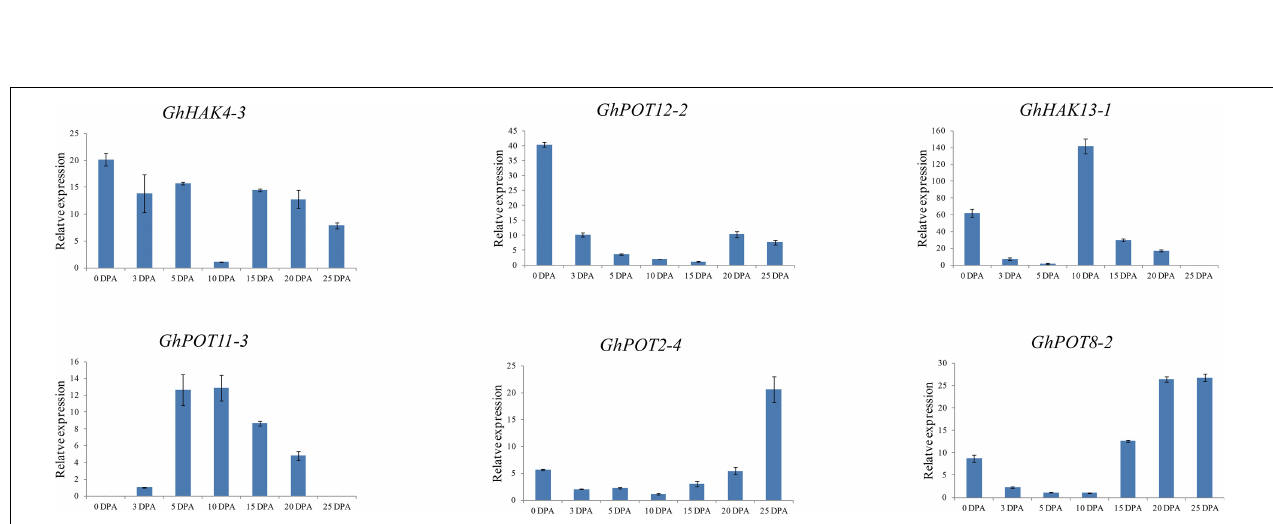
FIGURE 7 | Expressions of GhPOT genes in different fiber development stages. The expressions of the GhPOT genes were determined by qRT-PCR using the total RNA isolated from TM-1 fiber. The error bars indicate the standard error (SE) of three biological replicates. DPA (days post anthesis) is the sampling period.